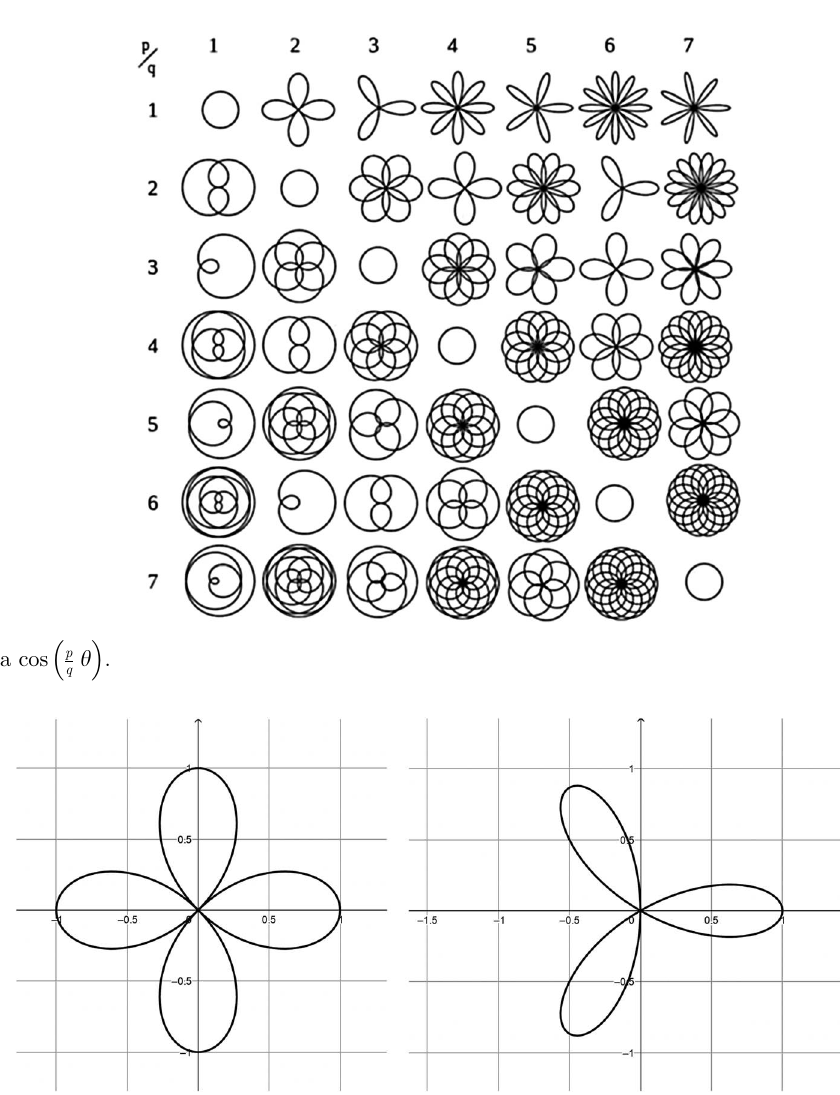
Figure 5. Rhodonea cos(2 h ) and cos(3 h